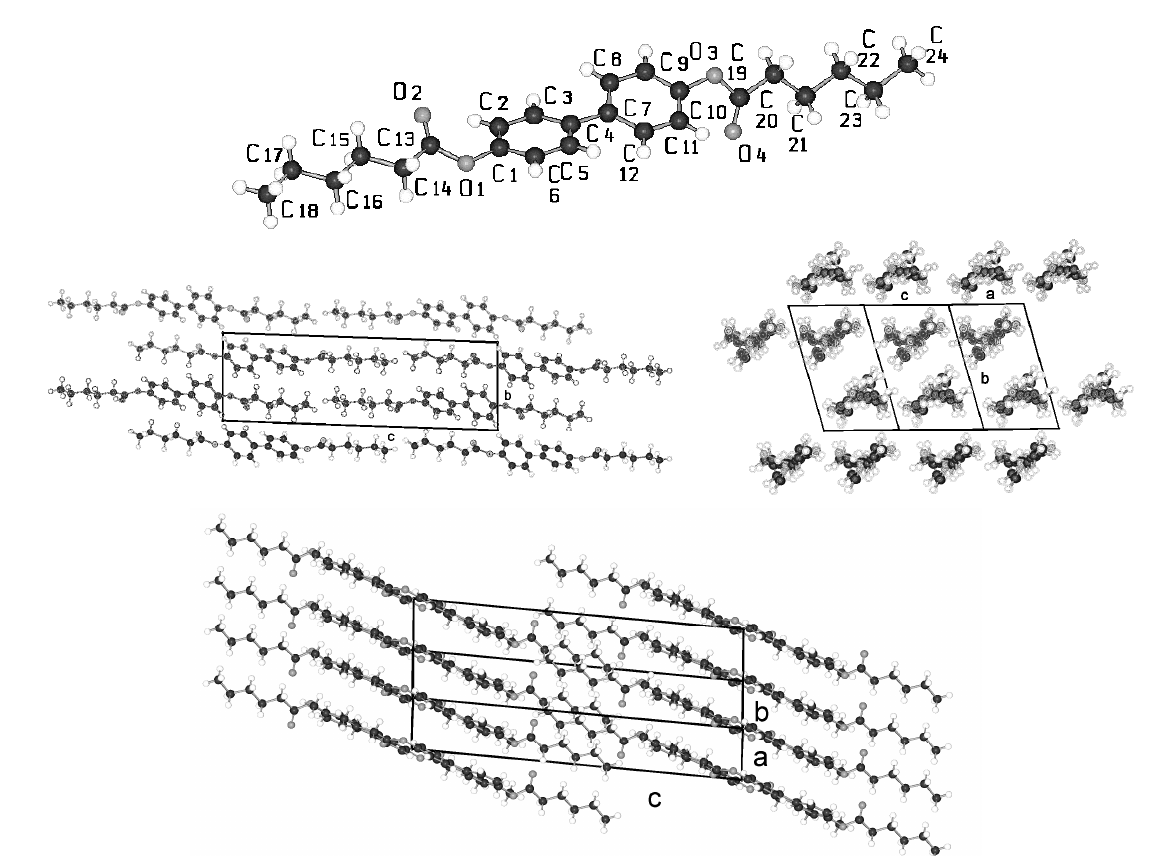
Figure 20. Representation of the asymmetric unit, respectively the molecular conformation of BP-5 with the numbering of the atoms. The planes of the two phenyl rings are twisted by 20.2° against each other. Also represented are the packing arrangements on the b,c-plane, down the molecular strings and along molecular